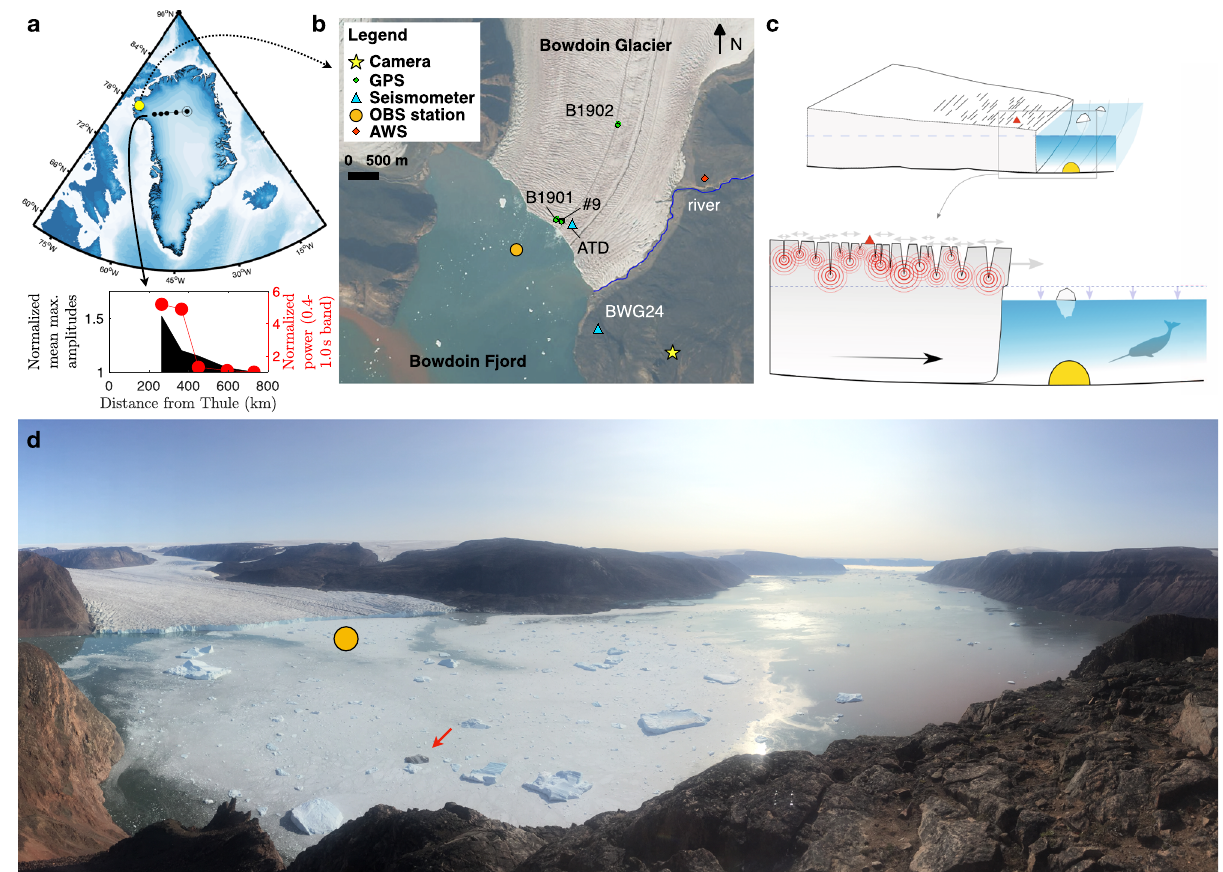
Fig. 1 Details of the study site, 2019. a Location of Bowdoin Glacier (yellow circle) relative to the 1967 Blue Trek seismic-noise survey (black circles), Greenland. The inset plot shows an increase in seismic noise from Inge Lehmann Station (open circle) to the coast; data are from ref. 29 . b Geophysical observational network on Bowdoin Glacier and its fjord (the background satellite image was acquired by Copernicus SENTINEL-2A on 27 July 2019; abbreviations correspond to the following: GPS Global Positioning System; OBS Ocean Bottom Seismometer; AWS Automatic Weather Station). c Schematic illustrating the key advantage of deploying an OBS directly under the calving front of a tidewater glacier to record subglacial and ocean seismo- acoustic signals, and minimise the impact of surface seismic sources (based on 35,36,48,58 ). d Photograph of the fjord after a major calving event, with the approximate OBS drop point identi fi ed by the yellow circle (29 July 2019; credit: E. Podolskiy). An iceberg with a debris-laden base is marked with an